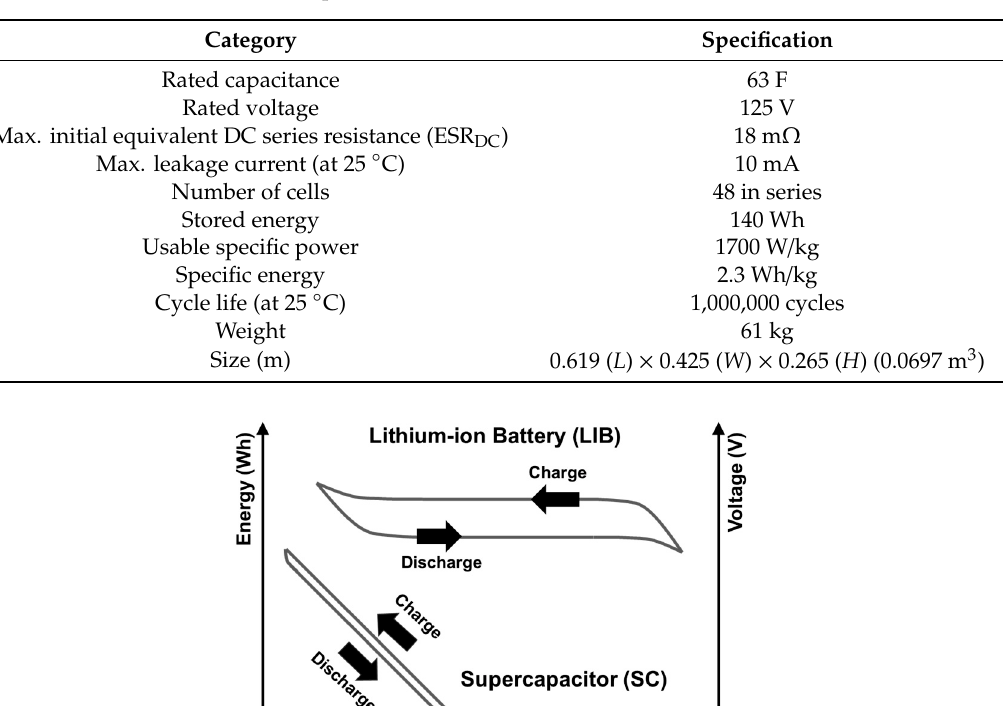
Table 9. Specifications of the selected SC module [30].